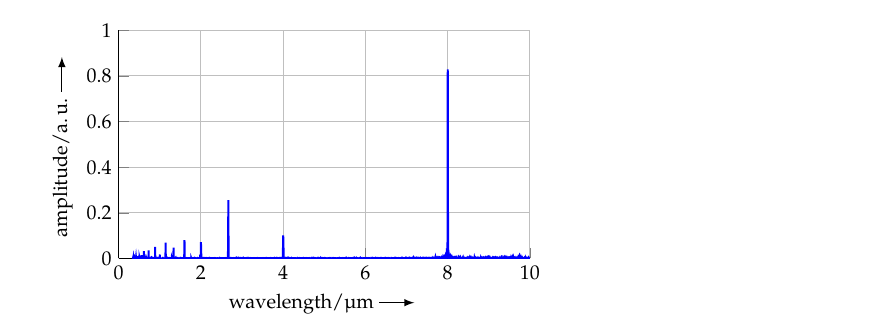
Figure 11. Normalised FFT of the measured profile. The maximum amplitude located at 8µm represents the mean pitch of the sample grating. Peaks at 4µm, 2.67µm, etc., result from the shape of the profile (see text).